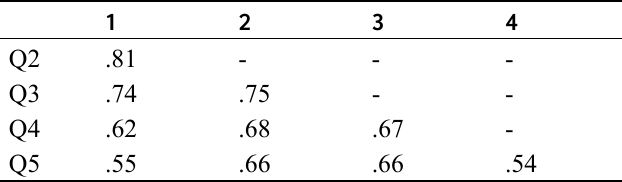
Table 2. Correlation matrix for the 5 items of the Santa Clara Strength of Religious Faith Questionnaire-Short Form.